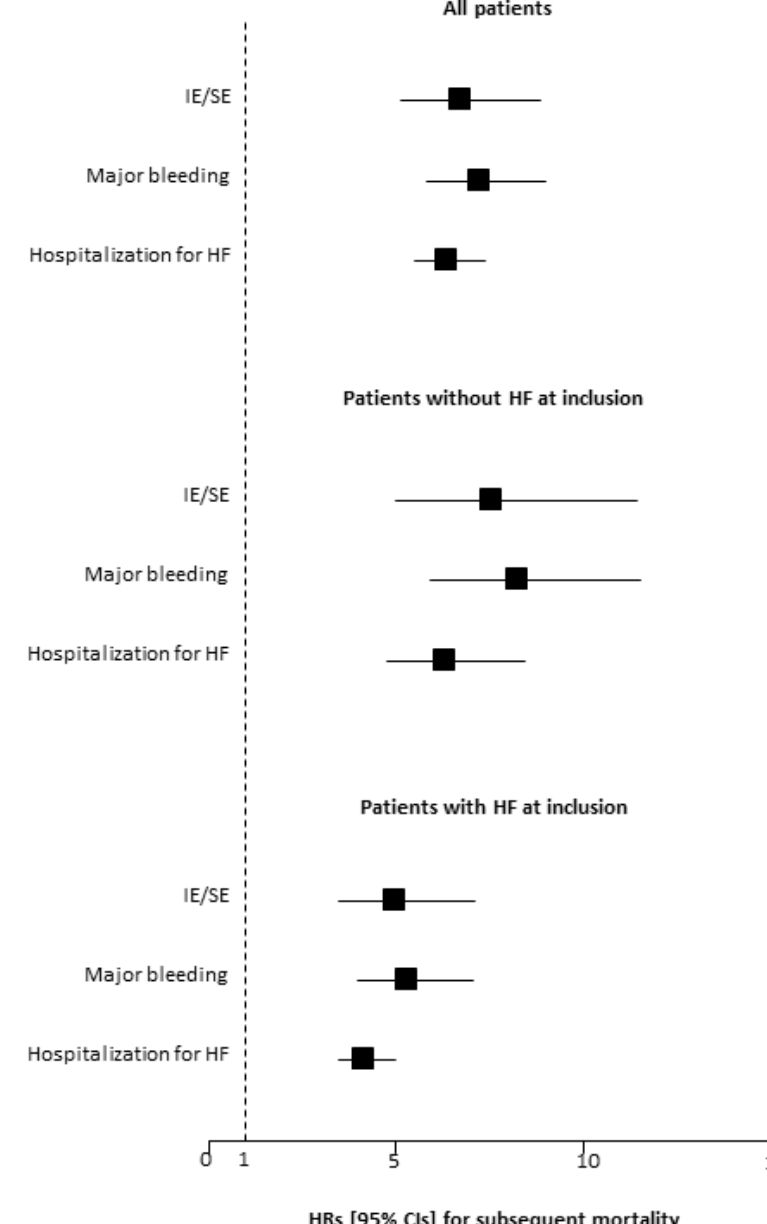
Figure 2. Impact of incident events on subsequent mortality during the follow-up period. Ischemic stroke/systemic embolism (IS/SE), major bleeding, and hospitalization for heart failure (HF) were analyzed as time-dependent variables. HR, hazard ratio; CI, confidence interval.